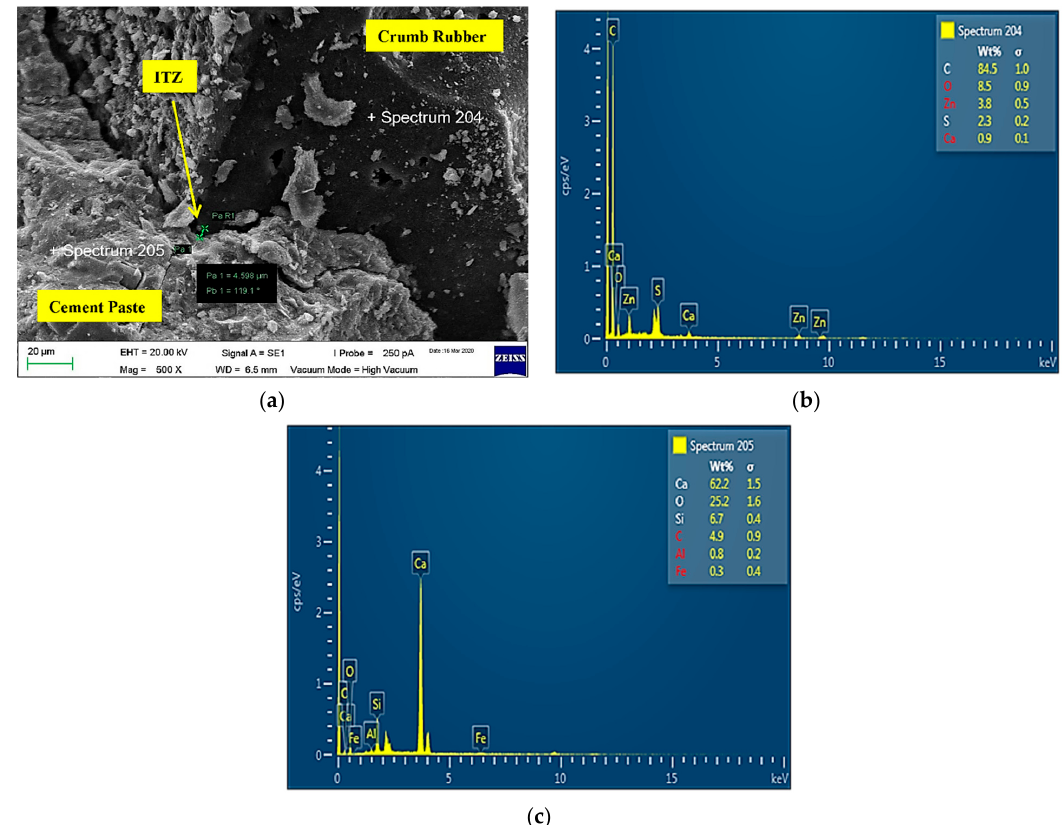
Figure 16. CR7.5-NS0 sample: ( a ) Microstructure ITZ = 4.598 μ m; ( b ) EDX of crumb rubber; ( c ) EDX of cement.